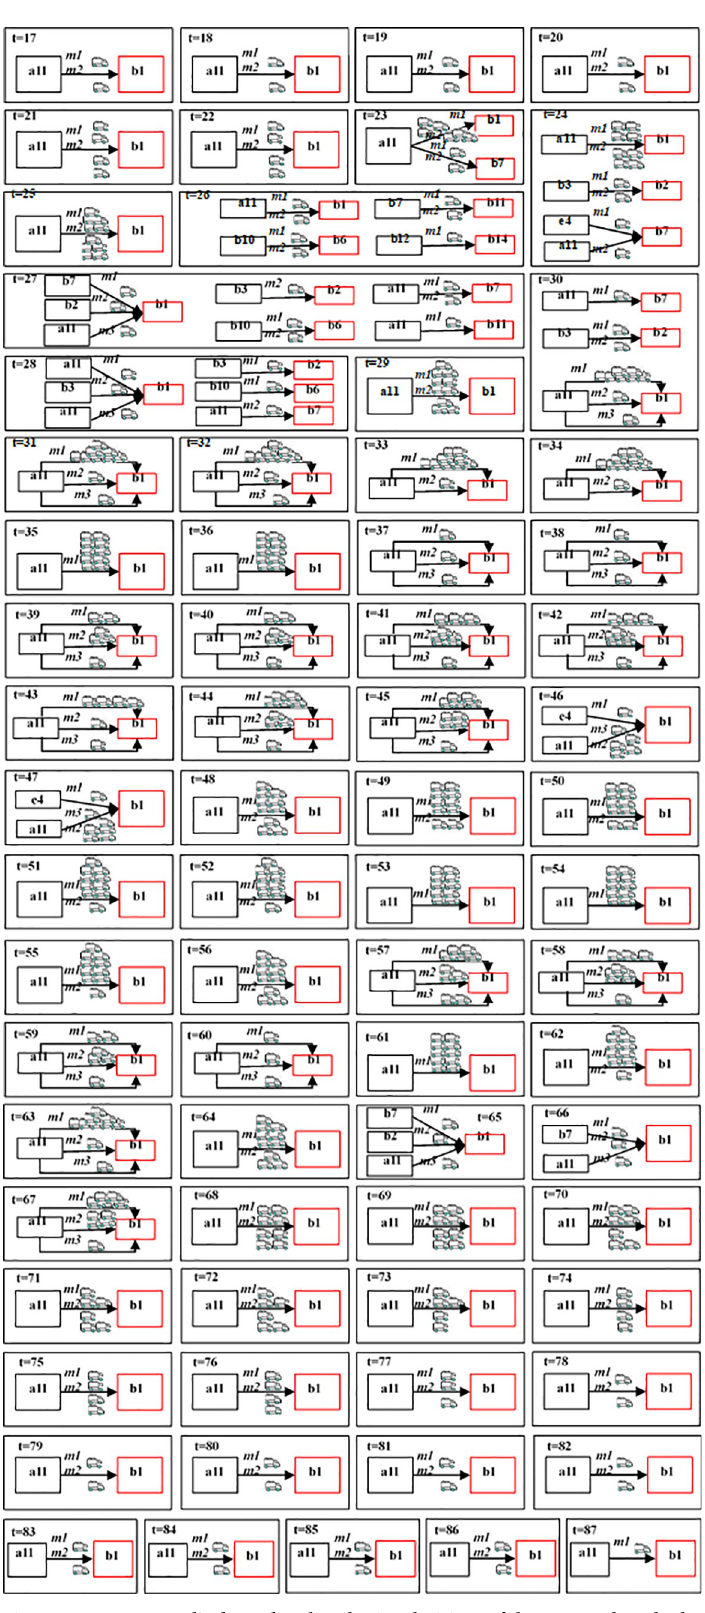
Fig 12. Emergency medical supplies distribution decisions of the proposed